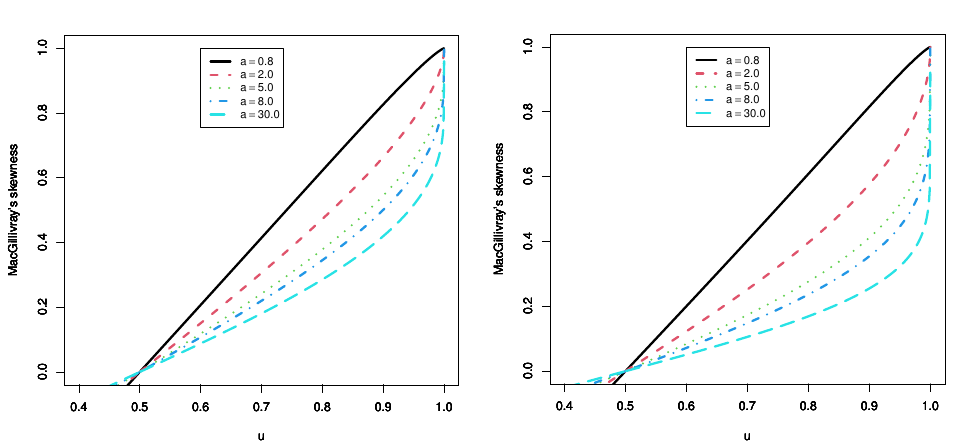
Figure 3. Plots of the MSK for the TCP-ITL distribution at β = 0.5 and 1.5.